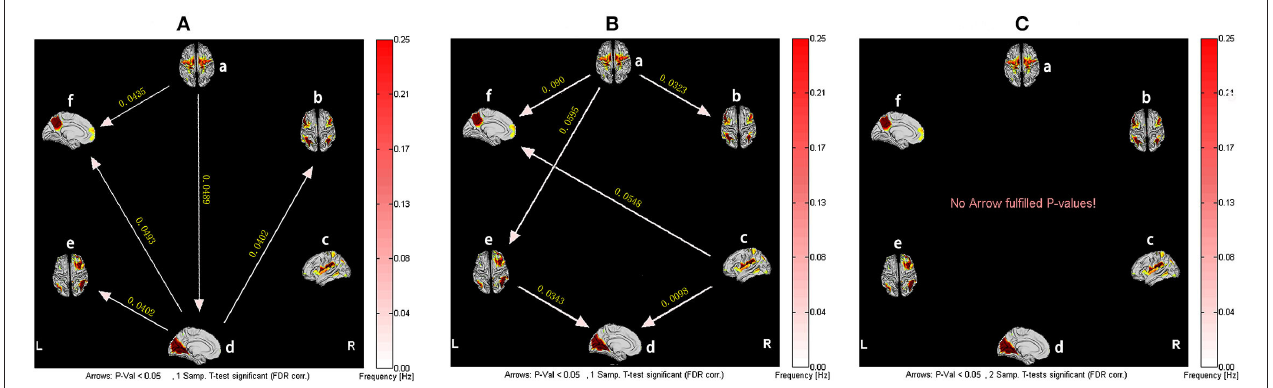
FIGURE 3 | The resting-state effective connectivity comparison of healthy subjects before and after Tai Chi Chuan training. There are six resting-state networks, including: a, SMN; b, ECN; c, SN; d, VN; e, RFPN; f, DMN. Arrow directions represent causal effect between resting-state networks. Yellow numbers indicate strength of causality. Values on the color bar (corresponding with arrow colors) demonstrate frequency at which causality was found. (A) One-sample t -test result of intergroup intranetwork causal relationship of the healthy controls after Tai Chi Chuan training. (B) One-sample t -test result of intergroup intranetwork causal relationship of the healthy controls before Tai Chi Chuan training. (C) Paired t -test result of intragroup intranetwork causal relationship of after Tai Chi Chuan training minus before Tai Chi Chuan training for healthy controls.